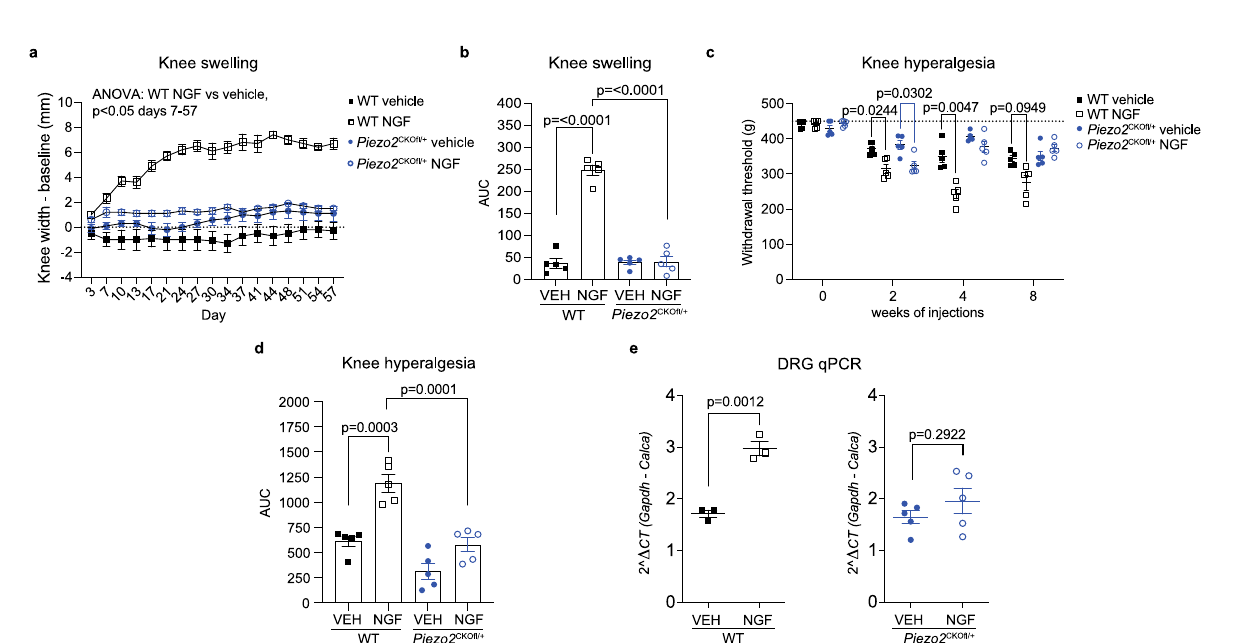
Fig. 7 | Piezo2 depletion protects from NGF induced knee swelling and mechanical sensitization. a Knee swelling was assessed in wild-type (WT) or heterozygous Piezo2 CKO fl /+ male mice given repeated intra-articular injections of recombinant murine NGF (i.a. 500ng, 5 µ L, 2x/week; WT=white squares; Piezo2 CKO fl /+ = white circles) or vehicle (5 µ L, 2x/week; WT= black squares; Pie- zo2 CKO fl /+ =blue circles) for 8 weeks; n =5 mice/group. Repeated measures two- way ANOVA with Sidak ’ s post-test: WT NGF vs. vehicle, p < 0.0479 from day 7 onward. Piezo2 CKO fl /+ , no differences between NGF vs. vehicle. b For the same mice as in a , area under the curve analysis over the time course was used to assess knee swelling. Two-way ANOVA with Sidak ’ s post-test. ( Piezo2 CKO fl /+